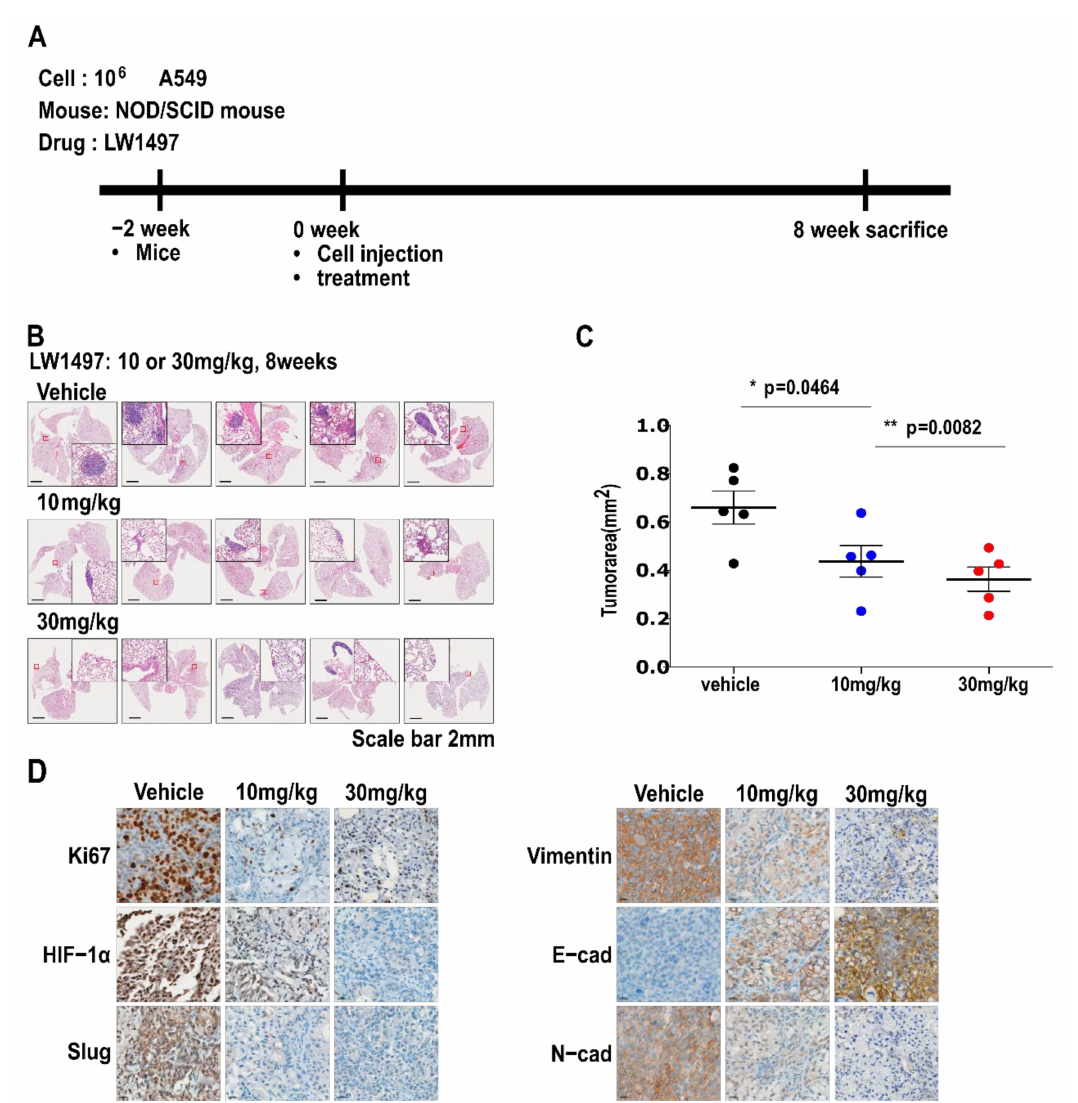
Figure 5. LW1497 suppressed lung cancer progression in a lung cancer orthotopic mouse model. ( A ) In vivo experimental protocol of A549 cells in NOD/SCID mouse using LW1497 drug as described in Methods section. ( B ) Hematoxylin and eosin staining of the lungs in LW1497- or vehicle-treated NOD/SCID mice injected with A549 cells. Lungs were analyzed by hematoxylin and eosin staining. ( C ) Comparison of tumor areas: mice treated with LW1497 versus mice treated with vehicle. Tumor areas were measured by intravital microscopic analysis (Axiotech Vario microscope, Zeiss, Germany). * p < 0.05, ** p < 0.01 compared with the control group. ( D ) Immunohistochemical analysis of Ki67, HIF-1a, Slug, and EMT markers including Vimentin (Vim), E-cadherin (E-cad), and N-cadherin (N-cad) in lung tumors in LW1497 (10, 30 mg/kg)- or vehicle-treated mice orthotopically injected with A549 cells into the